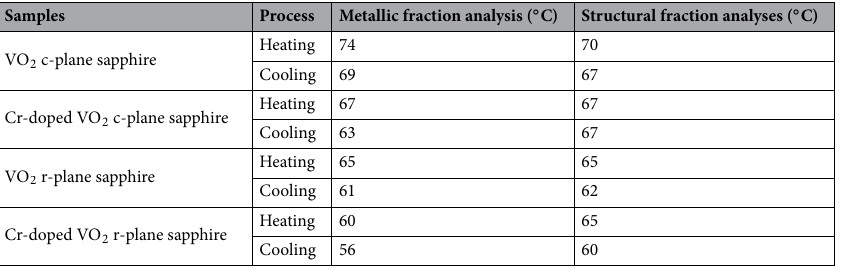
Table 1. Transition temperatures determined from fraction analyses of electrical and Raman